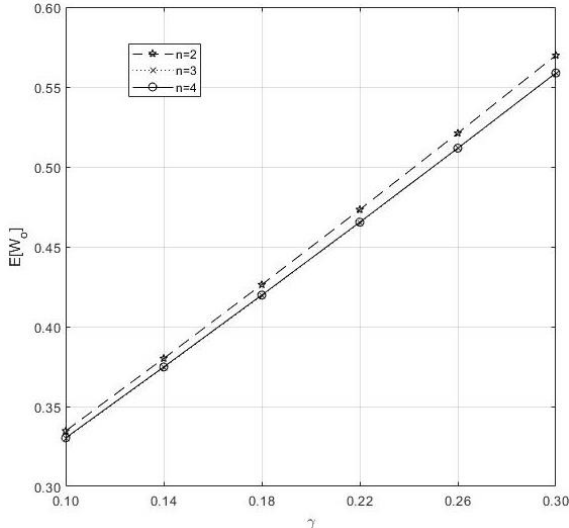
Figure 4. Impact of n and γ on the E [ W o ] .